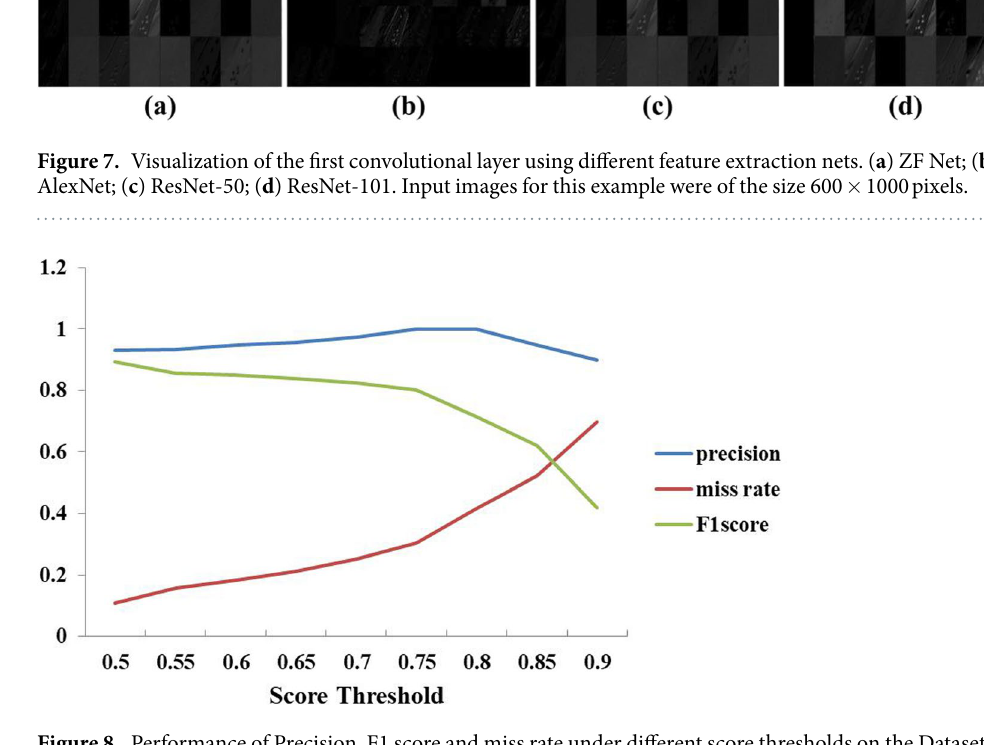
Figure 8. Performance of Precision, F1 score and miss rate under different score thresholds on the Dataset B. Score threshold is